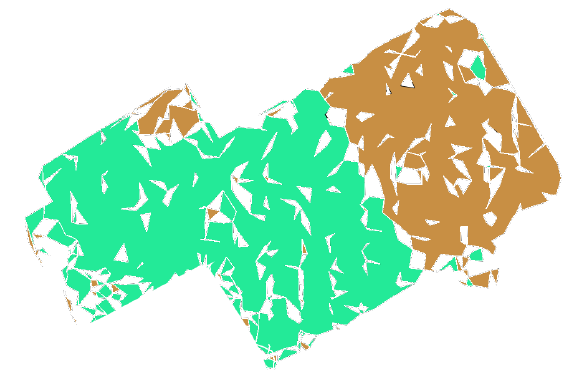
Figure 4. Classification of triangles according to the azimuth angles extracted from a 2D footprint and aggregation of the triangles to contiguous surfaces based on the azimuth